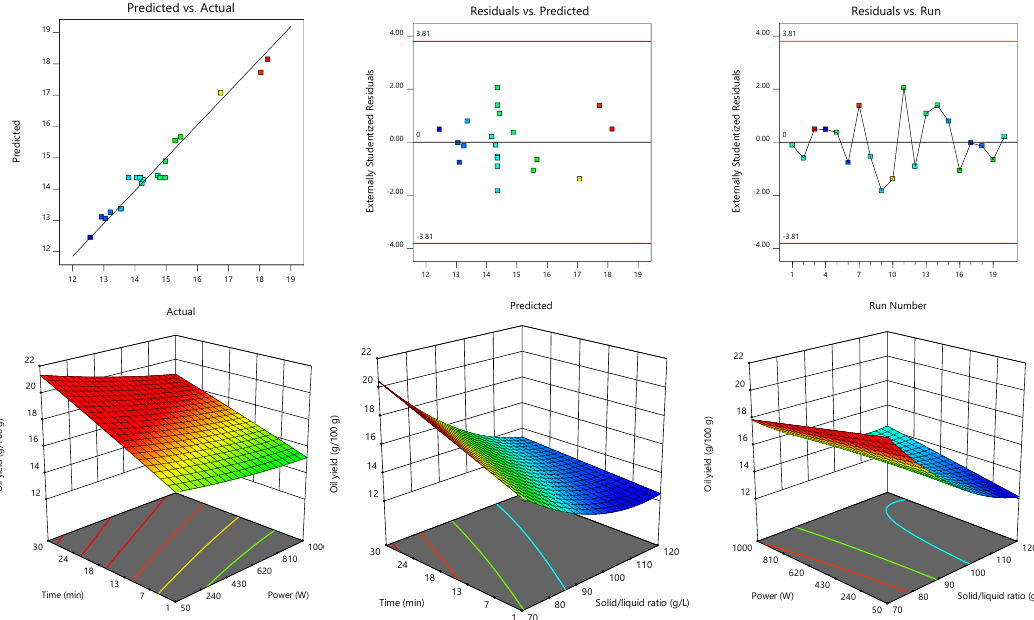
Figure 2. Response surface plots with statistical diagnostic representations illustrating the effects of the independent variables on oil yield (g/100 g) obtained from fish by-product S1 (unprocessed refrigerated sample). For each 3D plot, the excluded variable was fixed at its optimal value.